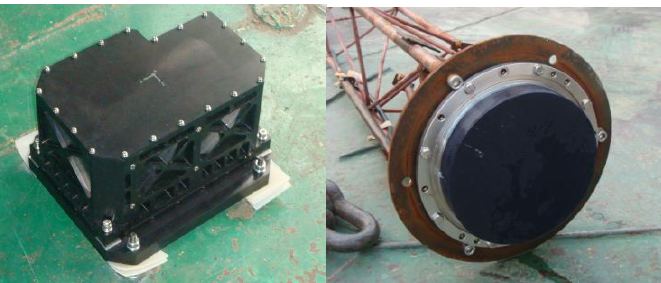
Figure 3. INS Kit and DVL